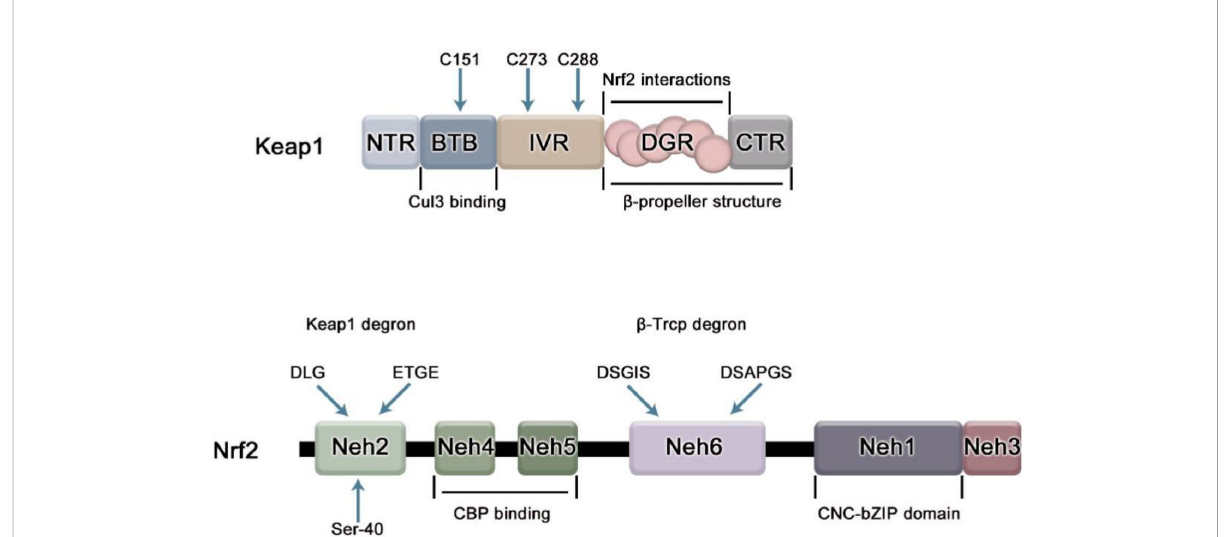
FIGURE 1 The domain structure of Nrf2 and Keap1. Keap1 has 5 domains. BTB domain mediates the homodimerization of Keap1 and its binding with Cullin3(Cul3), in which cysteine residue (C151) senses electrophilic compounds and mediates the dissociation of Nrf2 and Keap1; IVR region is related to the stability of Nrf2, and participates in the ubiquitination degradation of Nrf2 under non-oxidative stress. Cys 273 and Cys 288 on it are necessary to inhibit Nrf2; DGR domain mediates the binding of Keap1 to Nrf2. Nrf2 contains six domains, namely Neh1-6. The Neh1 domain contains a bZip motif, which mediates the dimerization of Nrf2 and sMaf, promotes the binding of Nrf2 and ARE, and is responsible for DNA recognition.; The Neh2 domain contains ETGE and DLG motifs required for interaction with Keap1; Neh3-5 acts as a trans-activation domain; The Neh6 domain contains DSGIS and DSAPGS motifs which can be recognized by b -TrCP linker